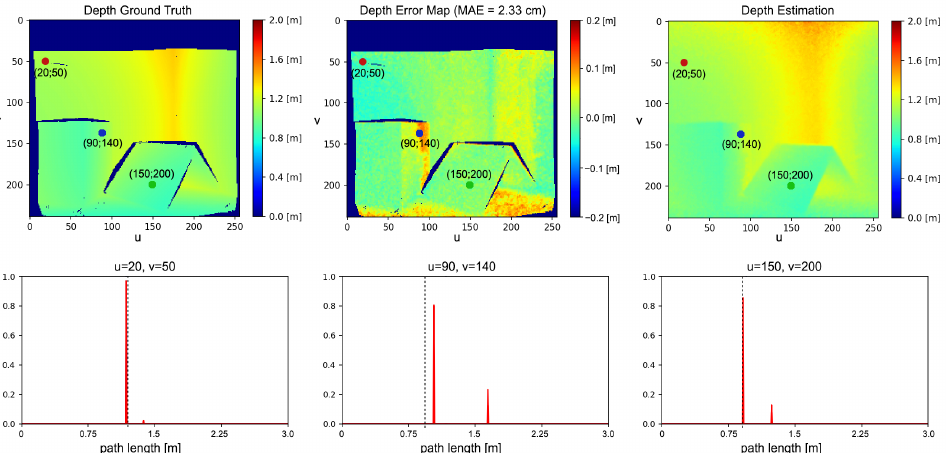
Figure 6. Network prediction for selected pixels in an image. The dashed lines correspond to the depth ground truth values while the red plots indicate the predicted backscattering